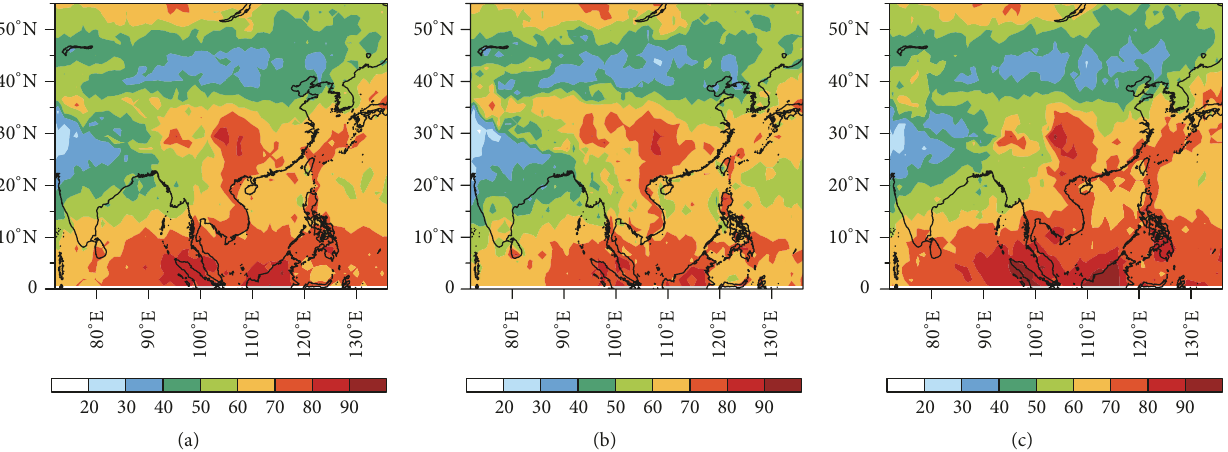
Figure 2: Horizontal distribution of the occurrence of cloudy skies during (a) the whole day, (b) day-time, and (c) night-time over China and surrounding areas, %.